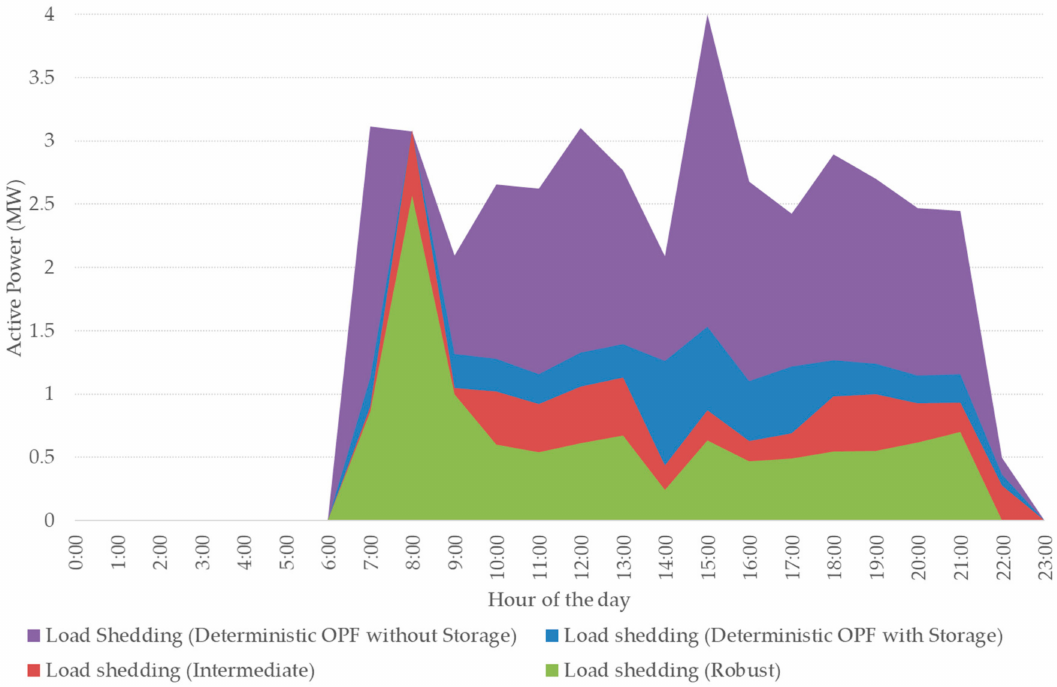
Figure 4. Load curtailments experimented by the feeder F1 for the no storage (certain deterministic OPF without storage), deterministic (certain deterministic OPF with storage), intermediate and robust cases on the winter working